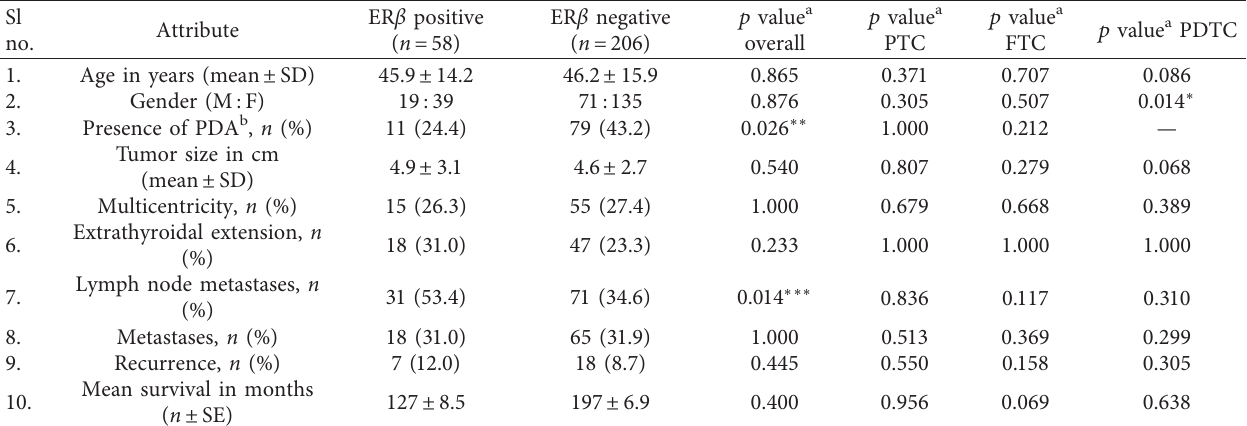
Table 2: Clinicopathologic correlation of ER β .